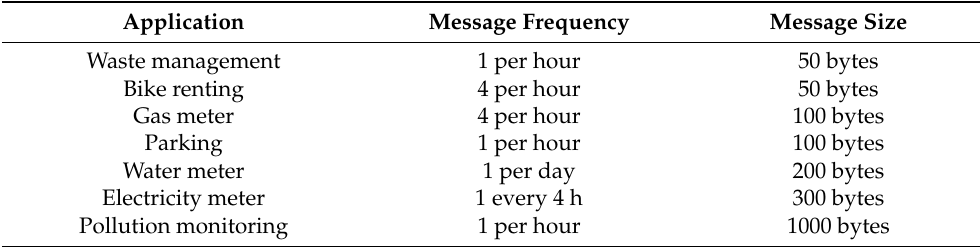
Table 5. Smart city applications that utilize NB-IoT, according to